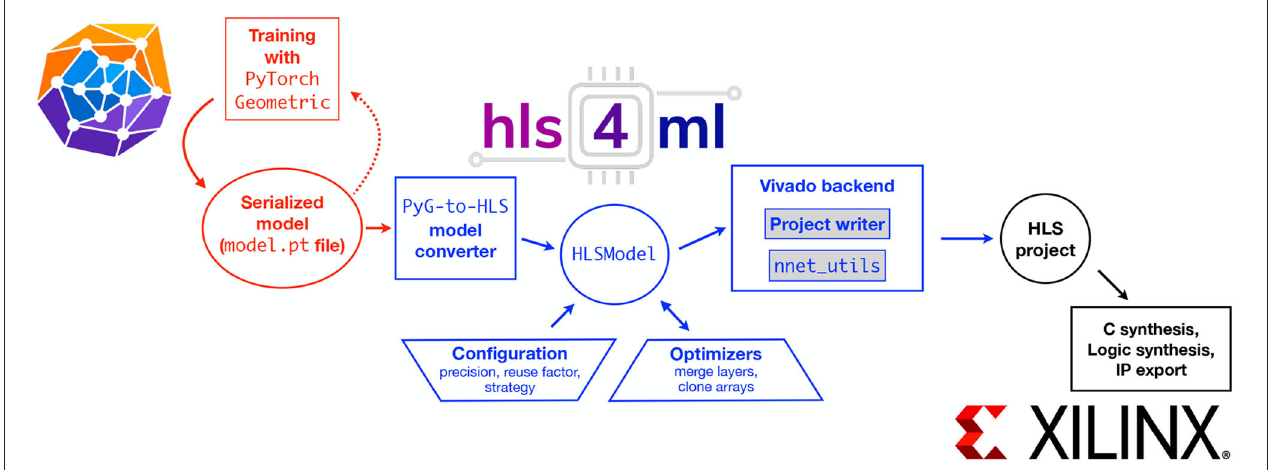
FIGURE 6 | The workflow to translate a GNN model into an FPGA implementation using hls4ml . The red boxes (left) describe the model training steps performed within ML software frameworks like PYTORCH GEOMETRIC . The hls4ml configuration and conversion steps are shown in the blue boxes (center) . A model converter translates the model from PYTORCH GEOMETRIC into an intermediate HLSMODEL representation. This representation can be further configured and optimized. Different backend writers can be used to export the model into a given vendor-specific language, such as Vivado HLS. The black boxes (right) illustrate possible ways to export and integrate the HLS project into a larger hardware design for example for Xilinx